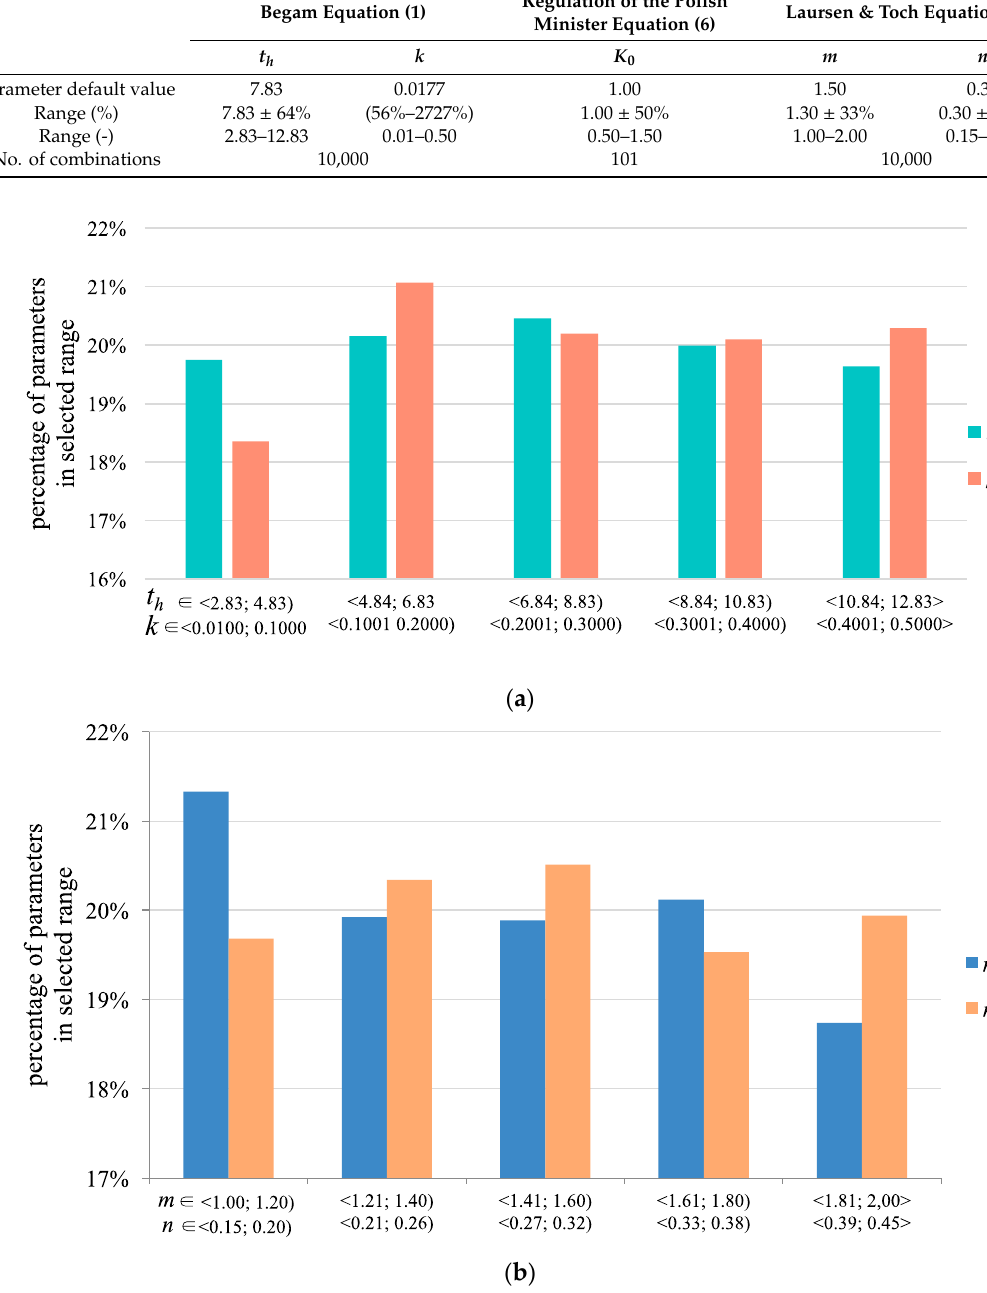
Figure 12. Distribution of the numerical value range of the function parameters in Monte Carlo sampling method: ( a ) Begam (1) formula (D ą bkowski et al. [5]), ( b ) Laursen & Toch (6) formula [12].